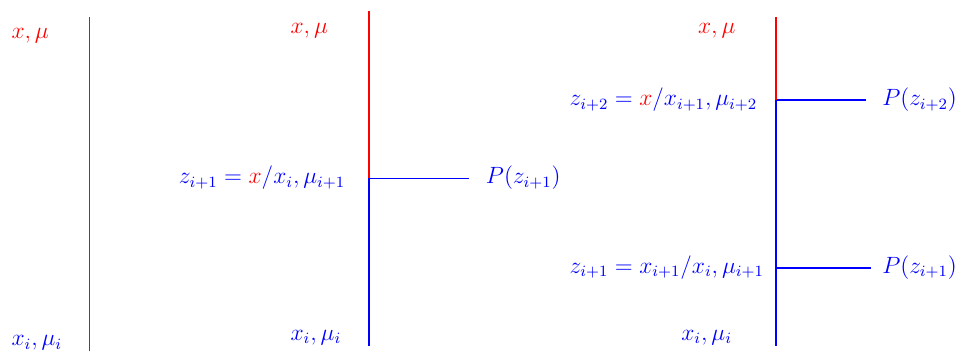
Figure 1 . Illustration of the evolution process by iteration: a parton can evolve from scale (cid:22) i to scale (cid:22) without any branching (left), having one branching (middle), two branchings (right) and so on. The relevant variables are